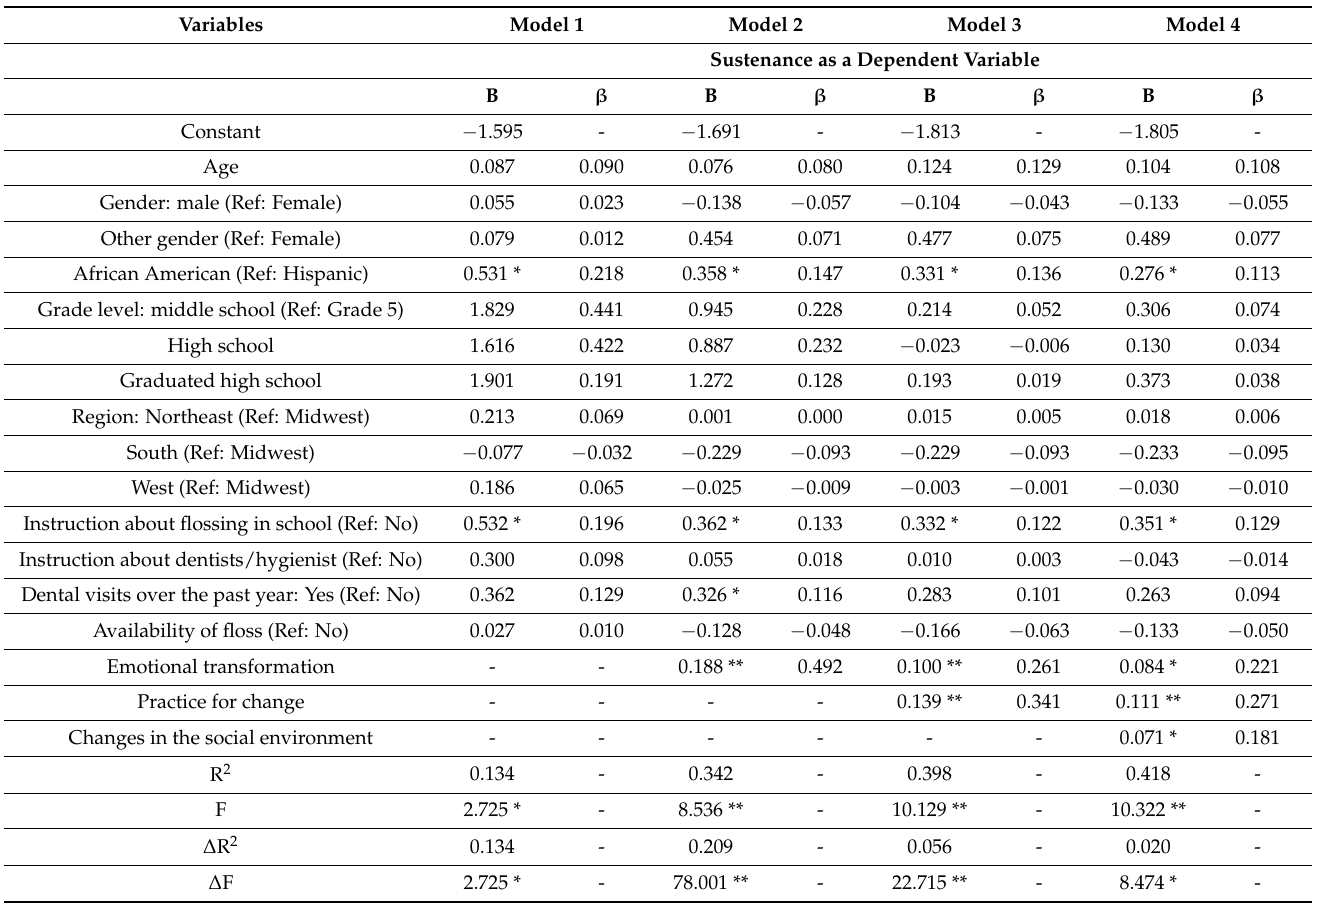
Table 9. Hierarchical multiple regression to predict the likelihood of sustaining flossing among participants who were not flossing (N =